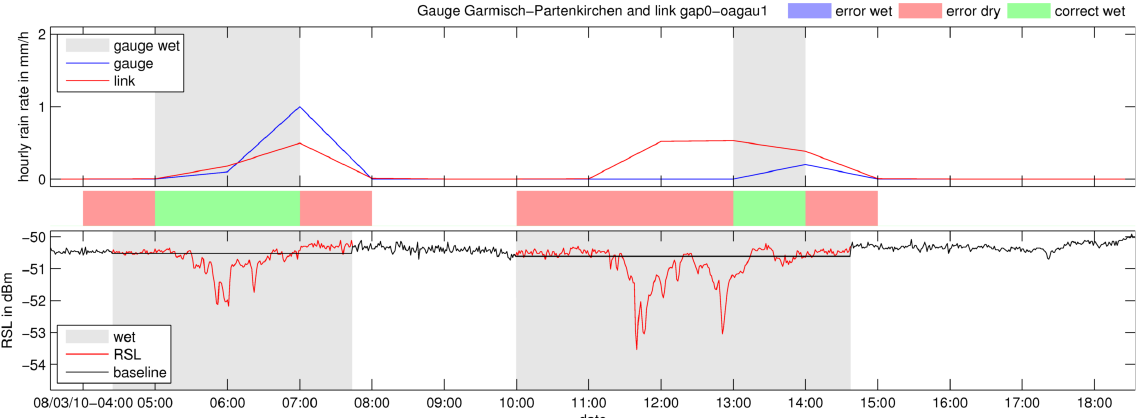
Fig. 6. Example of the limitations of the proposed wet/dry classification algorithm. Shown are time series of the minute resolution RSL data from the link gap0-gap4 (bottom plot in red), the hourly link-derived rain rate (top plot in red) and the hourly rain rate from the gauge Garmisch-Partenkirchen. Note: the hourly data are derived according to the DWD standard (e.g. 12:00UTC mean value is averaged from 10:50 to 11:50UTC) and the classification of a period as wet or dry applies for the whole hour before the value’s timestamp (e.g. from 11:00 to 12:00UTC for the 12:00UTC value). The colours indicating the errors correspond to the hourly